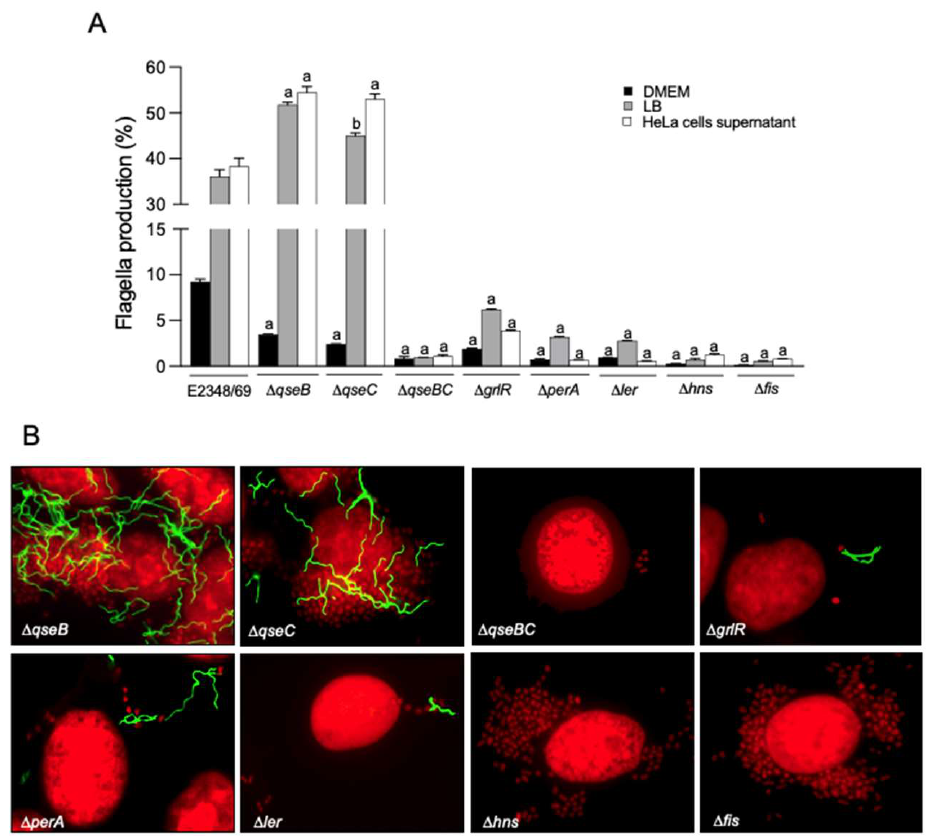
Figure 5. Influence of virulence and global regulators in the production of flagella. ( A ) Flow cytometry and ( B ) immunofluorescence were performed to determine the production of flagella by the indicated mutants. Immunofluorescence images were taken at 60 × . Data shown are the mean of three experiments performed in triplicate on different days. Letter a shows the statistical significance of the mutants tested with respect to E2348/69 grown in each condition (one-way ANOVA test, followed by Tukey’s multiple comparison), a = p < 0.001; b = p < 0.01.